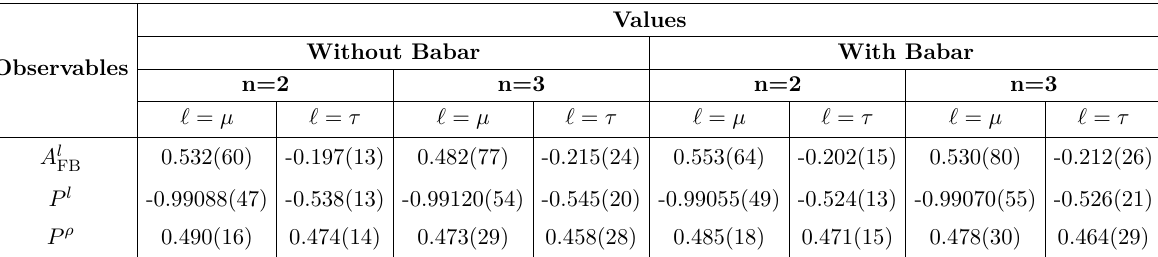
Table 9. SM values for angular observables related to the semileptonic B → ρ transitions for both n = 2 and n = 3 BSZ parametrizations of the form factors. The values are provided for both muonic and tauonic final states and corresponding to both the inclusion and exclusion of the Babar data from